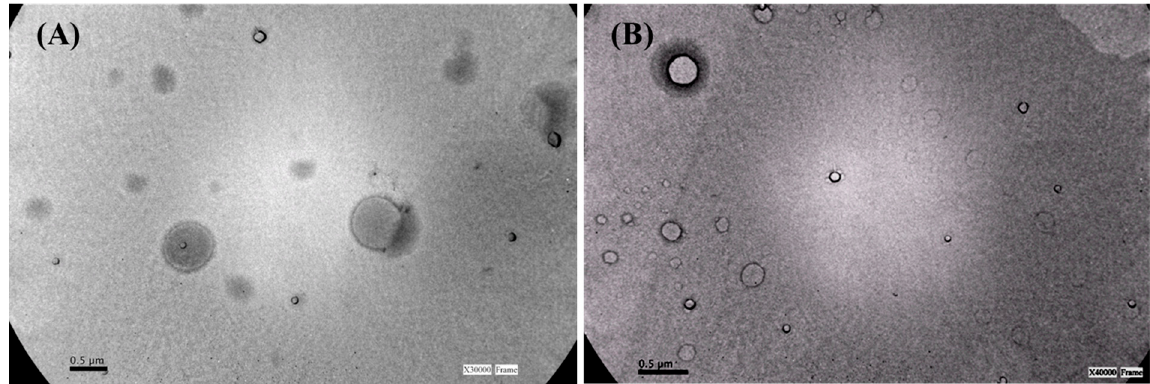
Figure 1. TEM photomicrographs of ( A ) RSV-Tw80:Sp80 niosomes and ( B ) RSV-Tw80:Sp80:Dod niosomes.